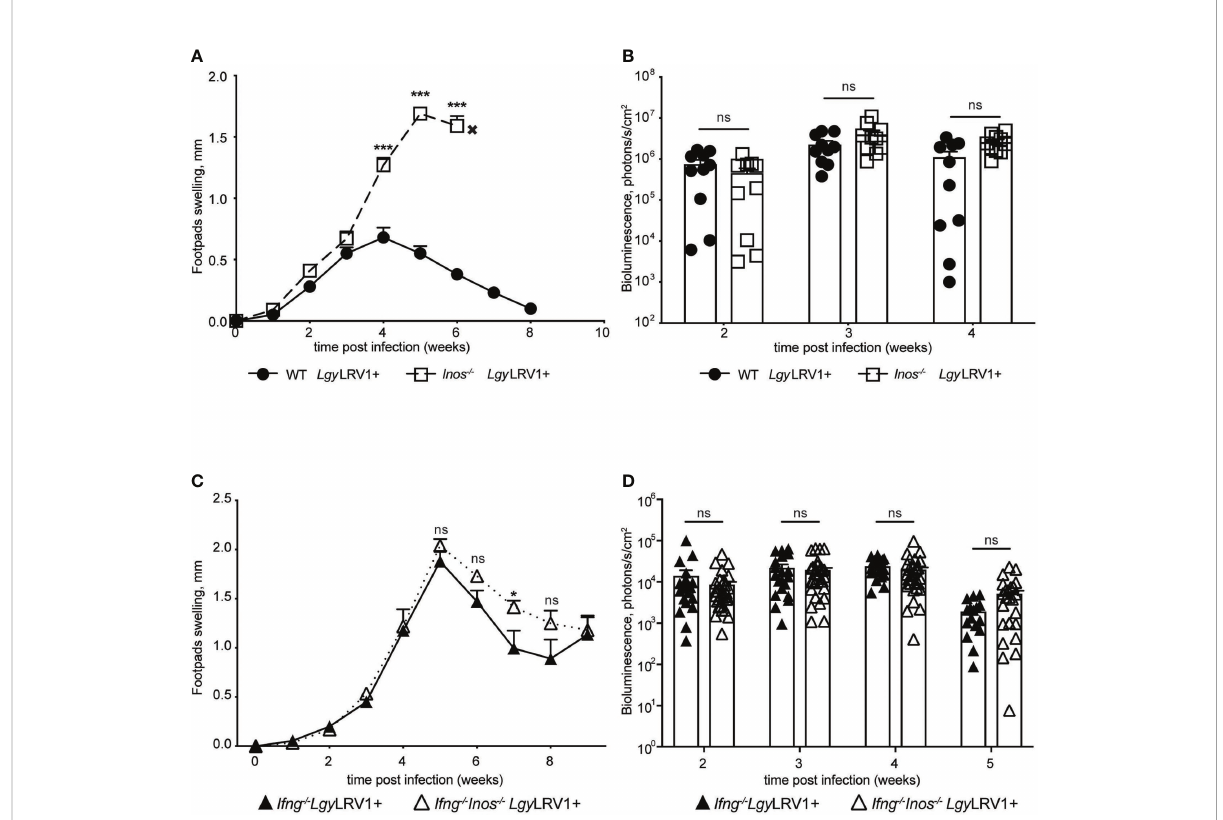
FIGURE 4 Type I IFNs mediated iNOS does not control Lgy LRV1+ infection in vivo . Hind footpads of WT, Inos -/- , Ifng -/- and Ifng -/- Inos -/- DKO mice were infected with 3 × 10 6 Lgy LRV1+. (A, C) – graphs display weekly measurements of footpad swelling. (B, D) Parasite burden was determined after infection by bioluminescence imaging. Data show mean ± SEM from representative experiments (n = 4 – 5 mice) of at least three independent experiments. Each data point on (B, D) represents one footpad. Statistical signi fi cance is calculated using two-way ANOVA analysis